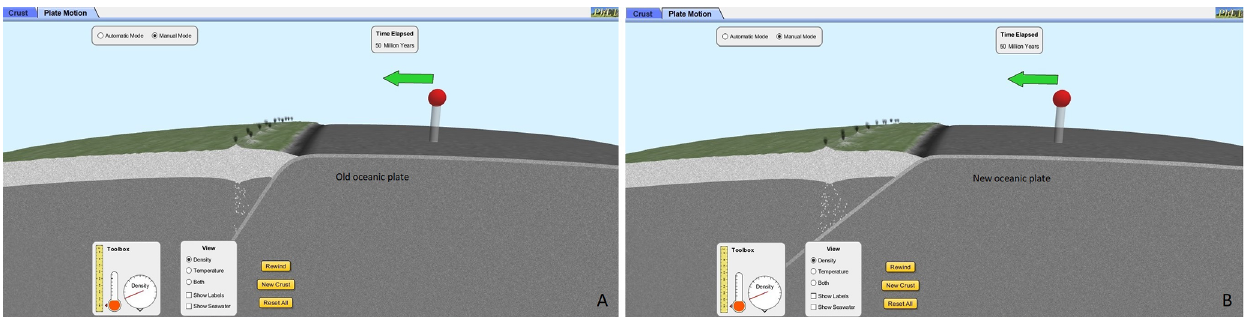
Figure 6. Location of volcanoes relative to the continental margin resulting from the collision between a plate with continental crust and an old oceanic plate (a) and a new oceanic plate (b) . Caption from PhET™ Plate